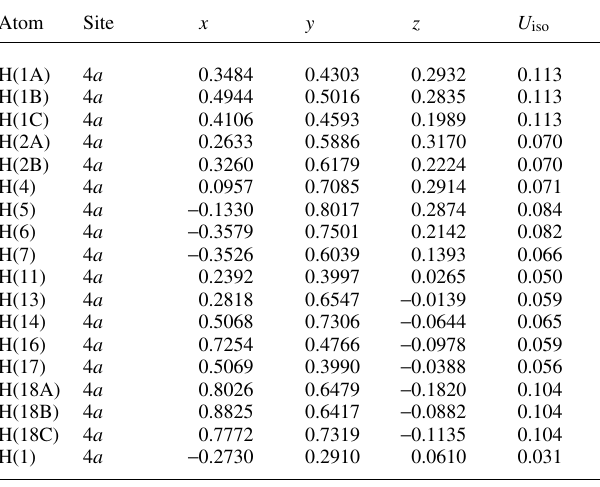
Table 2. Atomic coordinates and displacement parameters (in Å 2 )